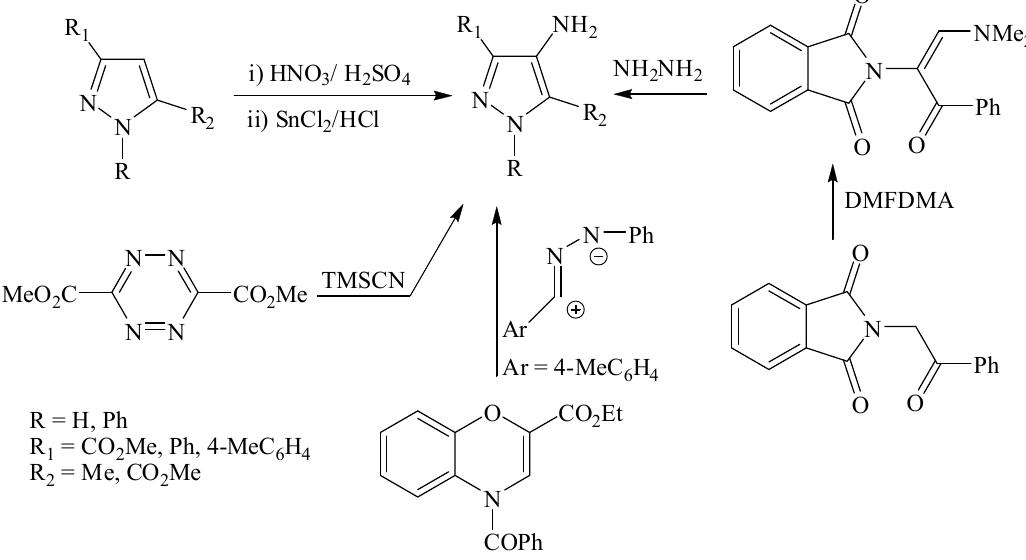
Scheme 1. Literatures preparation of 4-aminopyrazole